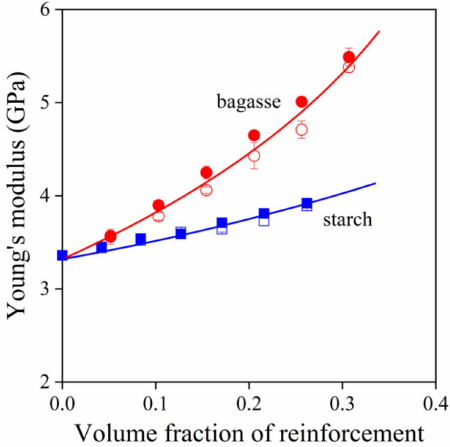
Figure 2. Composition dependence of the stiffness of PLA composites reinforced with starch or bagasse fibers. Effect of coupling. Symbols: ( , ) sugarcane bagasse fibers, ( , ) starch; empty symbols without MAPLA, full symbols with MAPLA.